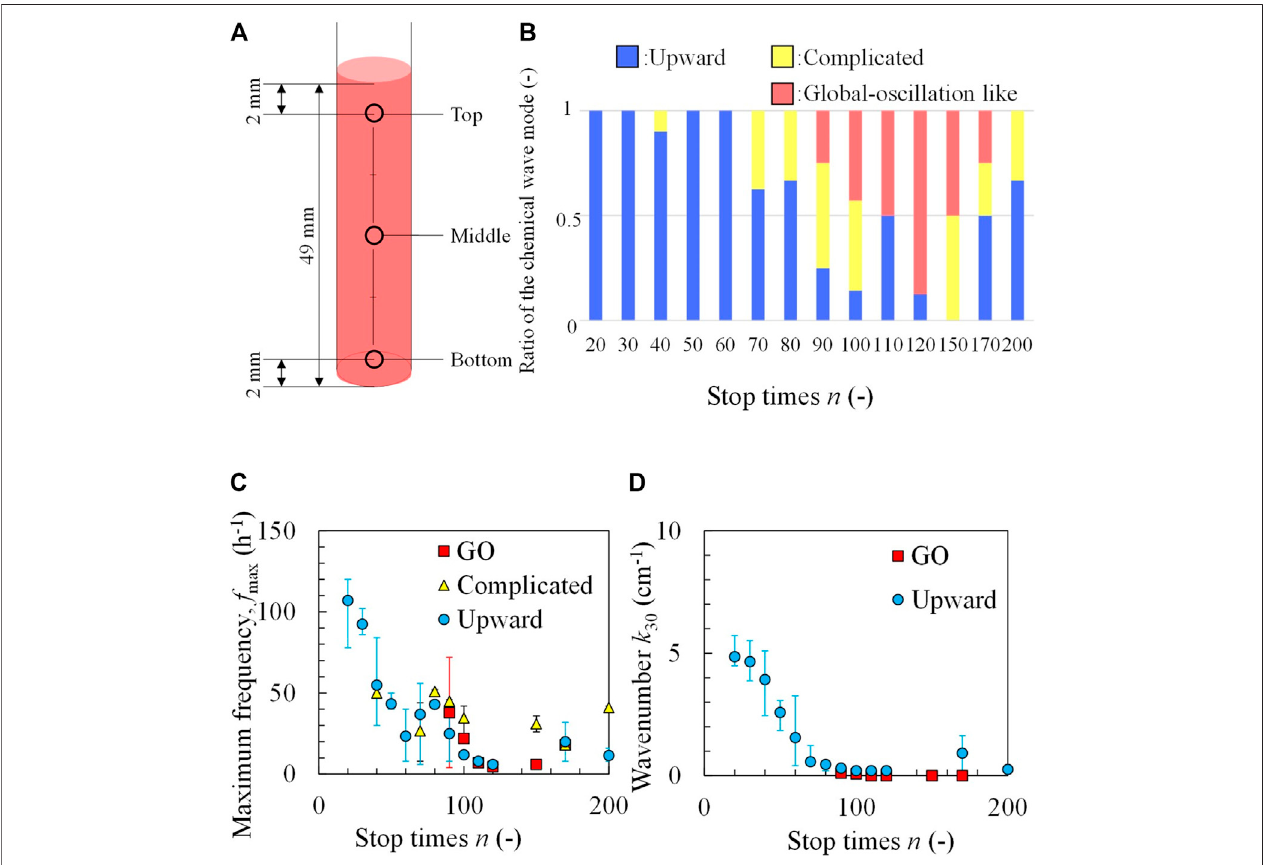
FIGURE 3 | Classi fi cation of the wave patterns by measuring the maximum frequency; (A) three measuring positions of the test tube, (B) ratio of three modes at different values of n . (C) Maximum frequency and (D) wavenumber as a function of n . GO indicates a global-oscillation-like pattern. The error bar represents the range covering the results of three times experiments.